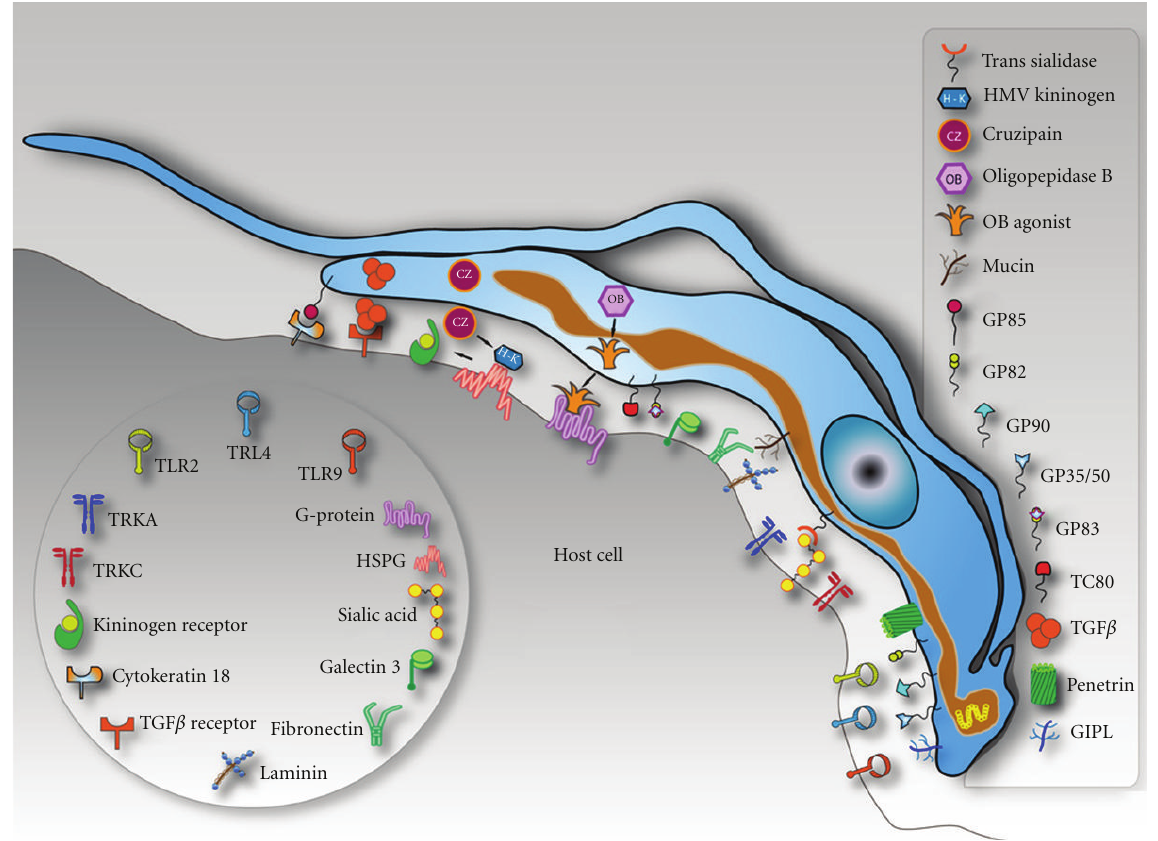
Figure 2: Schematic model summarizing the molecules involved on parasite-host cell interaction process and exposed on the surface of a hypothetical host cell and in trypomastigotes of Trypanosoma